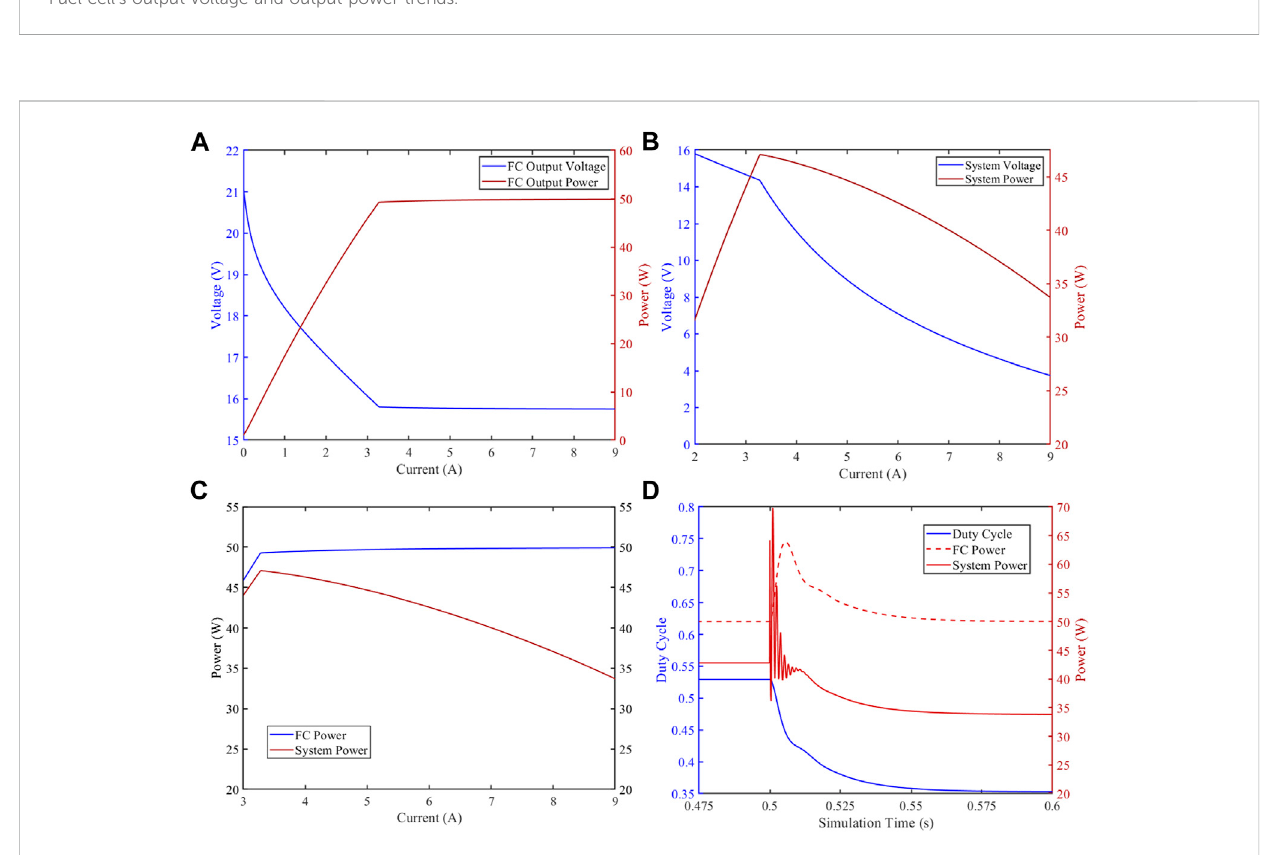
Simulationresultsofthesystem-levelmodel. (A) Powerandvoltagechangesatthefuelcellstack ’ soutputport. (B) Powerandvoltagechangesatthe converter ’ s output port. (C) Comparison of powers of fuel cell and system output. (D) Transient response of the